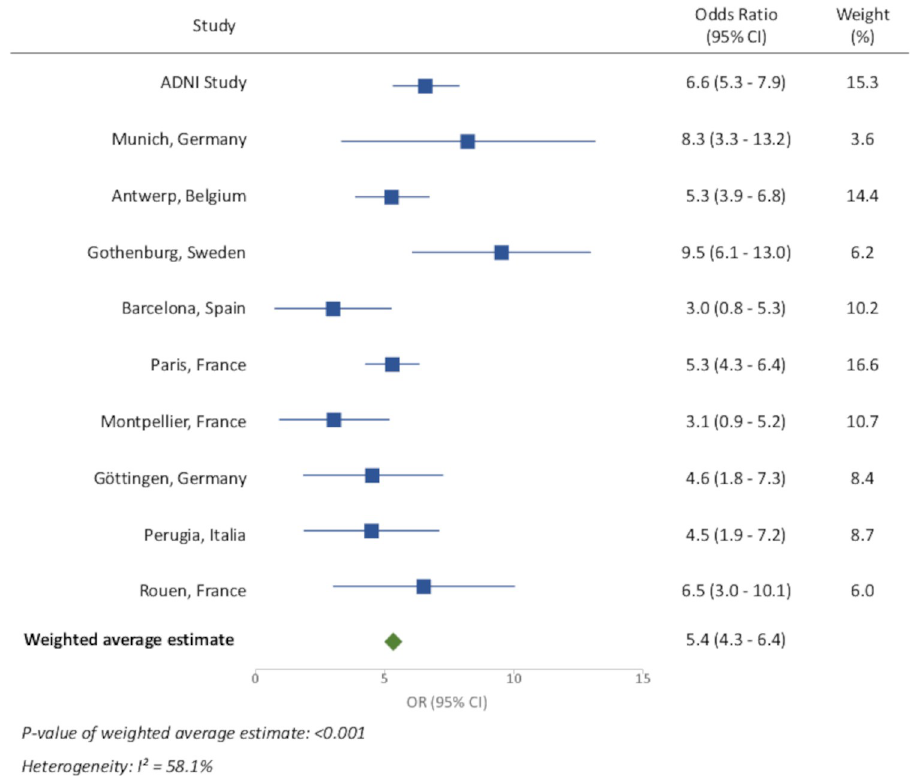
Fig 6. Association between APOE ε 4 carrying and AD stratified by center, using general population group as controls. AD, Alzheimer disease; APOE , apolipoprotein E; CI, confidence interval; OR, odds ratio.